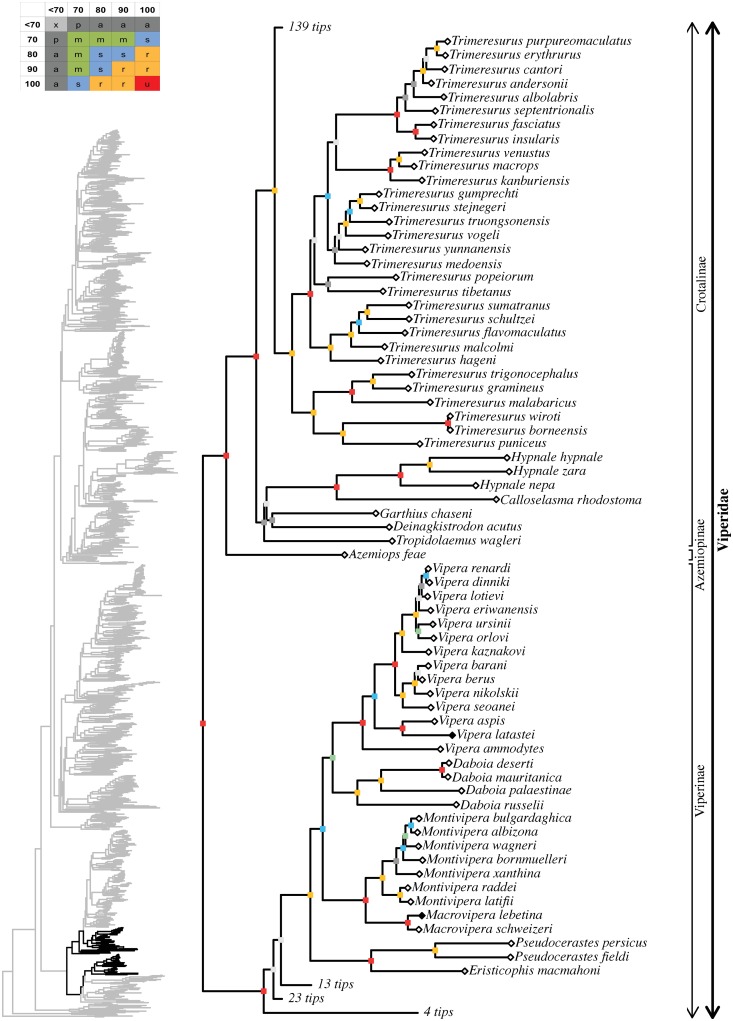
Maximum likelihood species-level phylogeny of Colubroides
(continued).Family Viperidae, subfamilies Viperinae, Azemiopinae, Crotalinae.